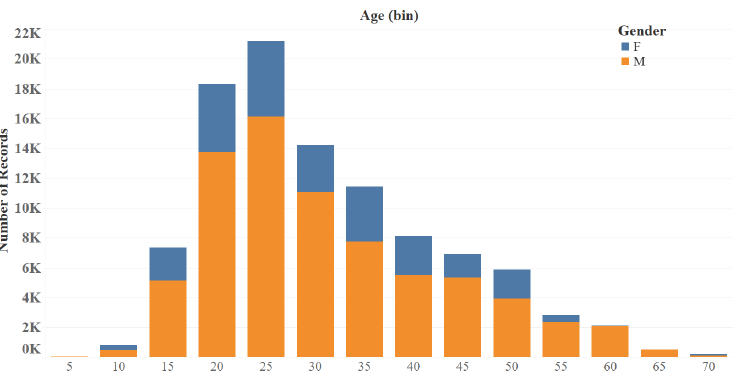
Figure 3. MovieLens age/gender distribution.